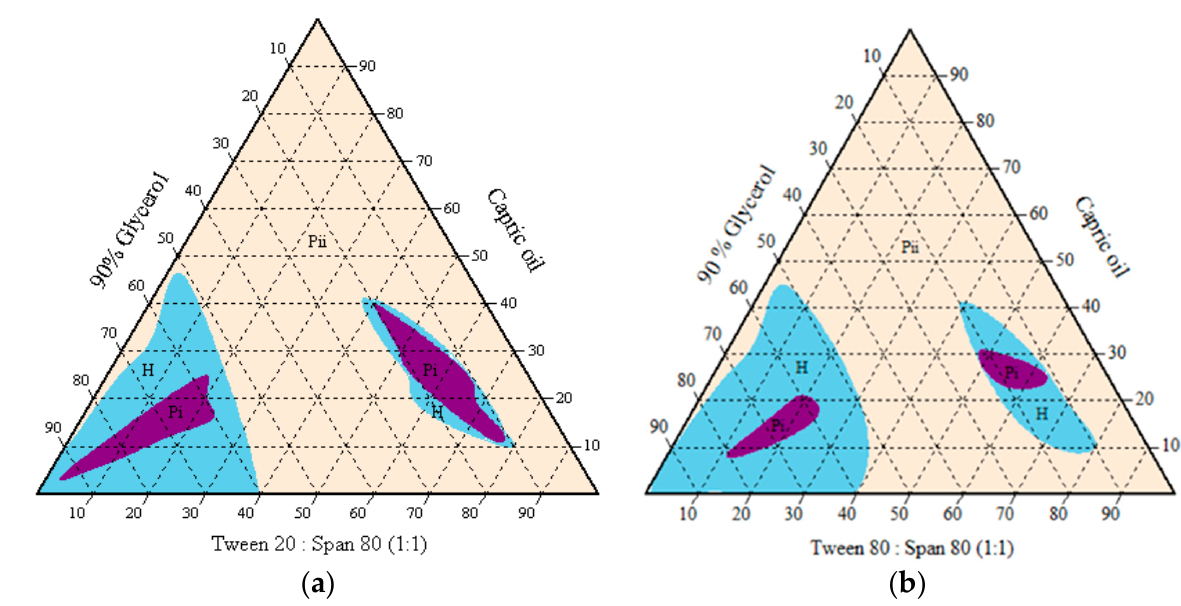
Figure 4. Pseudo-ternary phase diagrams of capric oil/surfactant/water/glycerol systems without active ingredients, using single or mixed surfactants ( a ) Tween 80, and ( b ) Tween 20. H = homogenous cloudy and milky; P i = one-phase/ transparent; P ii = multiphase.